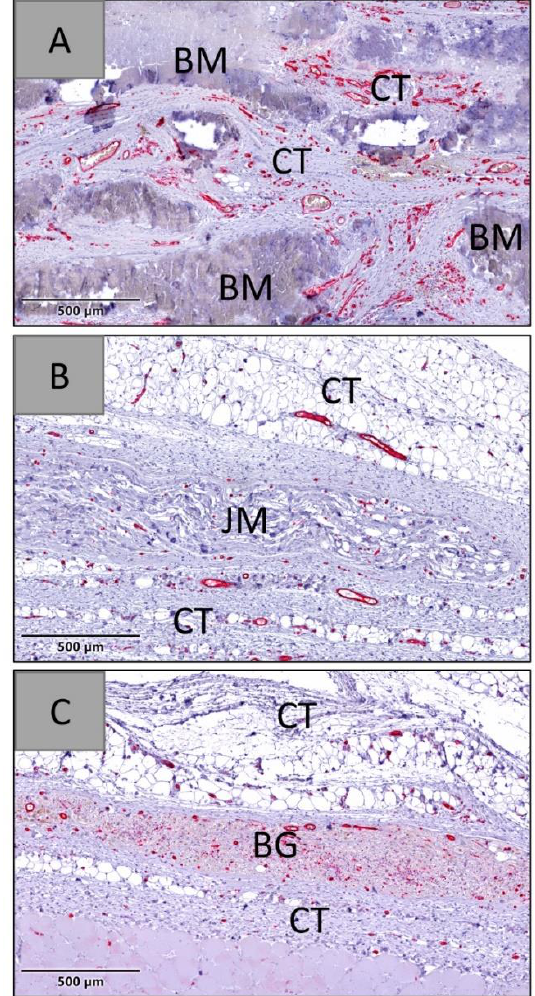
Figure 15. Exemplary histological images of the three membranes within the subcutaneous connective tissue (CT) at day 90 post implantationem. ( A ) BM = native bovine membrane, ( B ) JM = Jason ® membrane, ( C ) BG = Bio-Gide (CD31-immunostainings, 20× magnifications, scalebars = 500 µm).